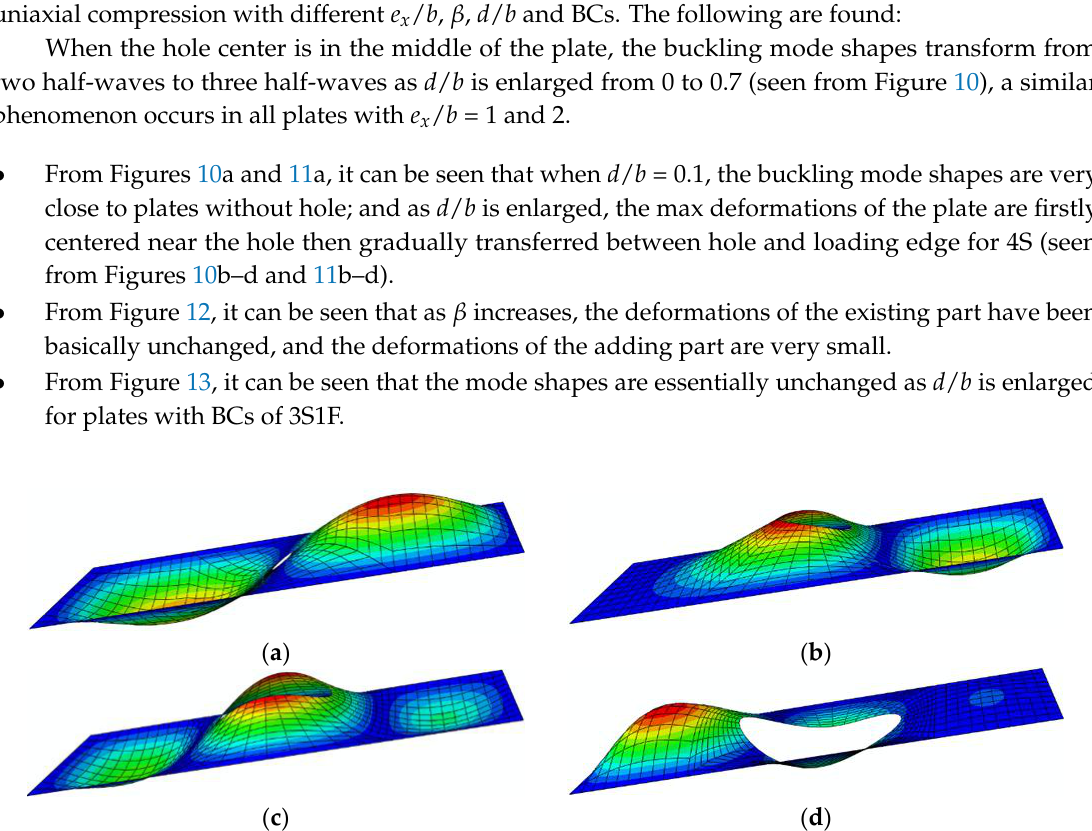
Figure 10. The model shapes of plates with e x / b = 1, β = 2 and BCs of 4S. ( a ) d / b = 0. 1 ; ( b ) d / b = 0.3 ; ( c ) d / b = 0.5 ; ( d ) d / b = 0.7.